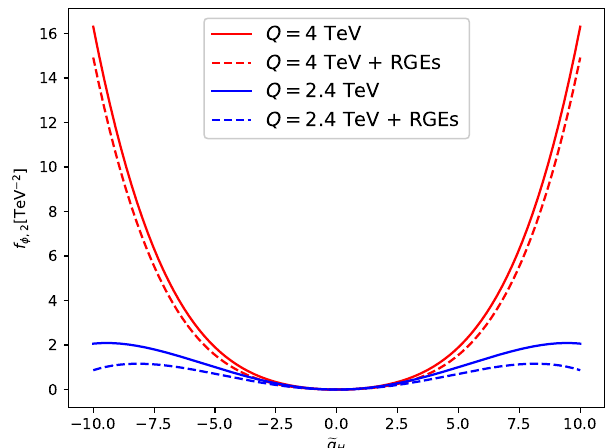
Figure 5: Wilson coefficient f φ as a function of ˜ g at different values of the matching H 2 = 4 TeV and all other UV couplings set to zero. The dashed lines scale Q for fixed m V include approximate RG